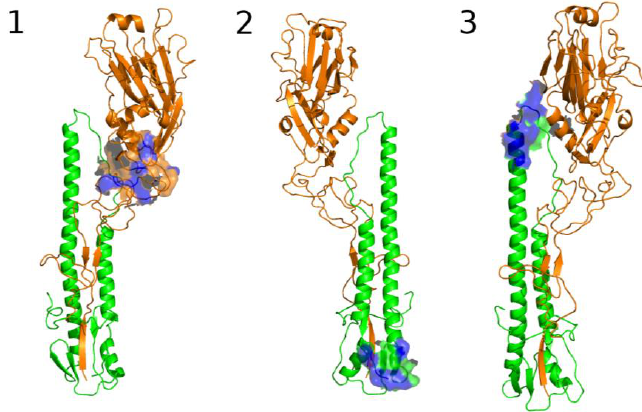
hence blocking the essential function of HA which is membrane fusion.